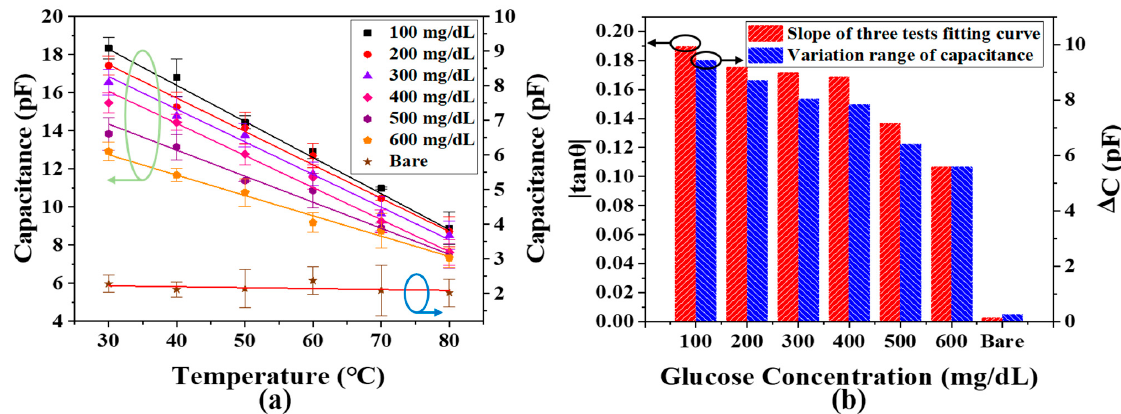
Figure 6. ( a ) The response of the bare chip and capacitor to different concentrations of glucose solution at the temperature range of 30–80 °C; ( b ) the change of slope for the fitting curve between different concentrations of glucose solution and capacitance, and the change range of capacitance with temperature.